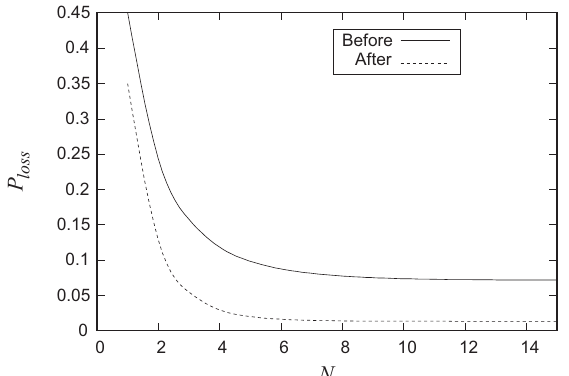
Figure 14. Dependence of the probability P loss on the number N .